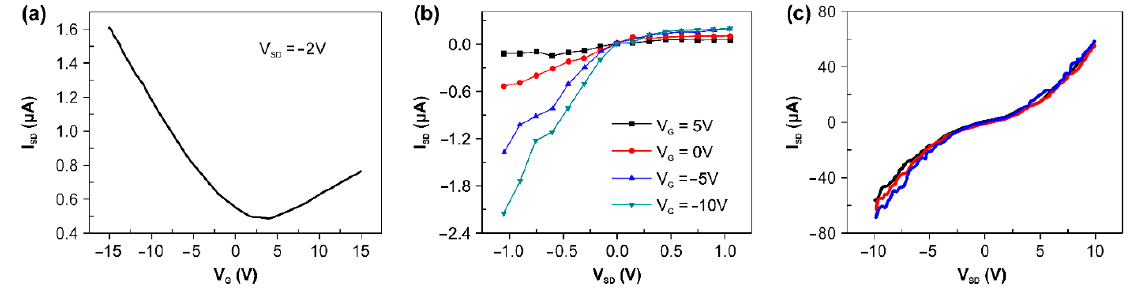
Figure 2. Electrical properties of the all-CNT–based device. ( a ) Transfer characteristics of the CNT device measured at V SD = − 2 V. ( b ) Output characteristics measured with V G from − 10 to 5 V in 5 V steps. ( c ) Output current as a function of V SD measured at V G = 0 for 3 different bending conditions (radius of curvature: 15 mm (black line), 35 mm (red line), relax (blue line). Insert: image of CNT device attached to a curved surface.